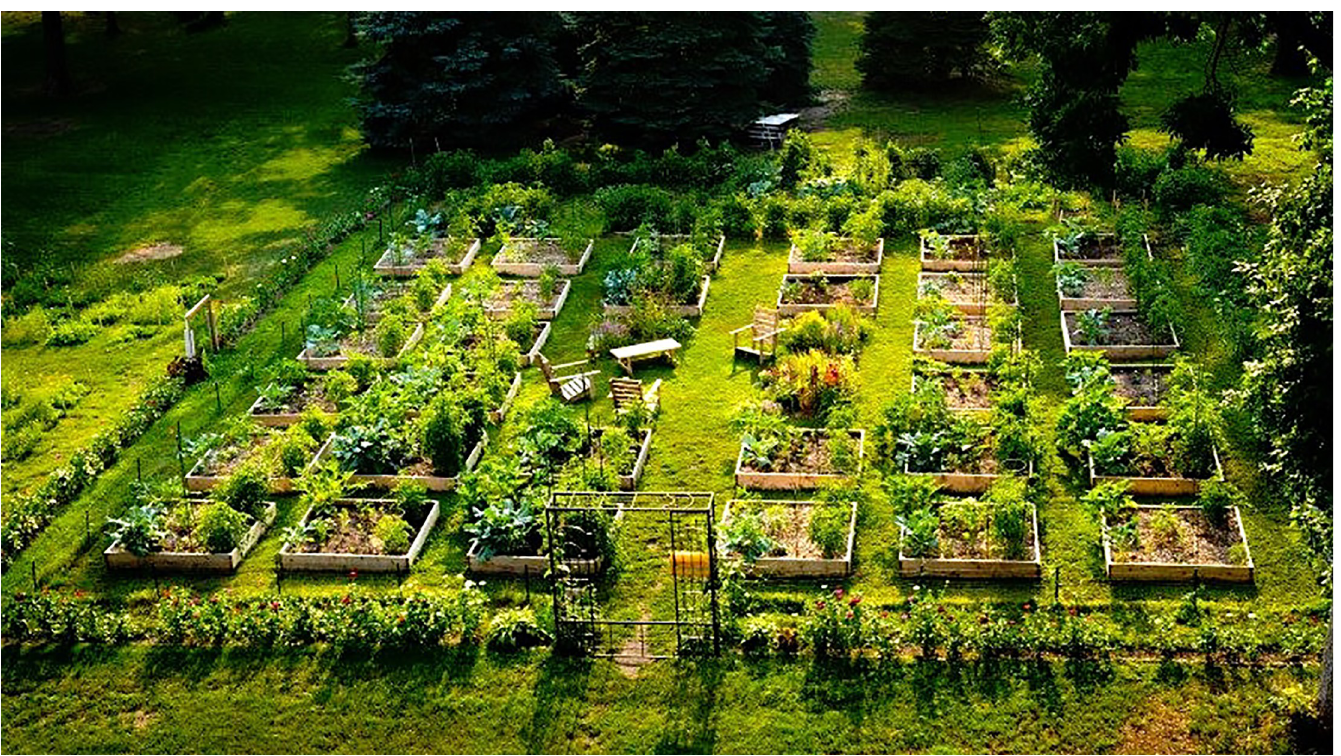
Fig 1. Experimental layout of the garden plots at the University of Saint Thomas